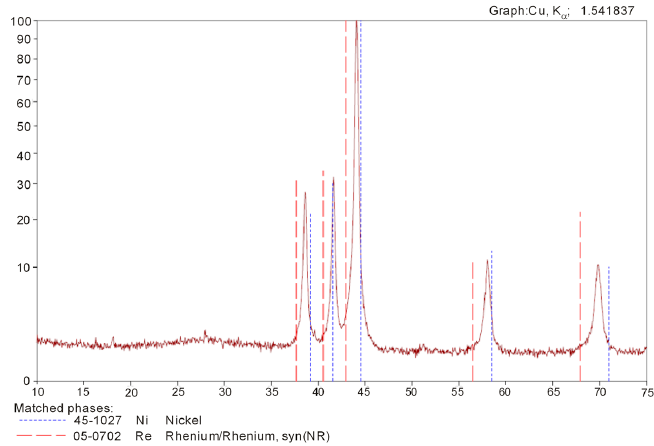
Figure 4. Diffractogram of Re-Ni alloy powder produced by Ni(ReO 4 ) 2 reduction at 800 °C for 1 h.